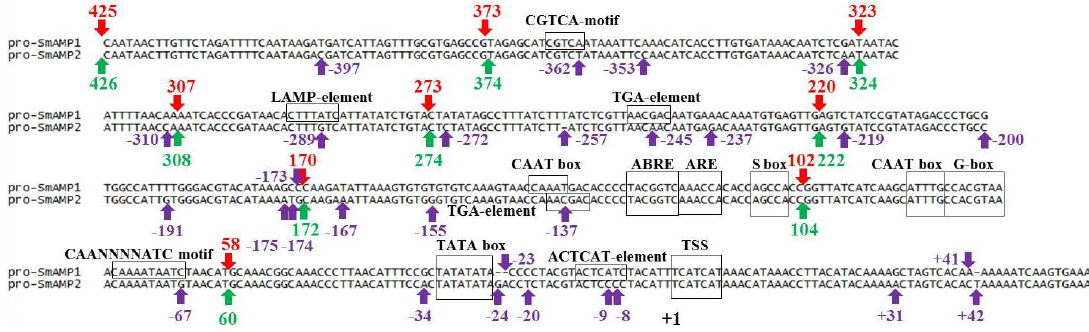
Figure 2. Alignment of pro-SmAMP1 and pro-SmAMP2 promoters and 5′-untranslated regions (UTRs). Letters in black above boxes indicate cis -acting elements. Purple arrows indicate point mutations; numbers above and below the arrows indicate their positions from the transcription start site (TSS) of the pro-SmAMP2 promoter. Red and green arrows show new deletion variants of the promoters; +1 is the first nucleotide of the TSS.